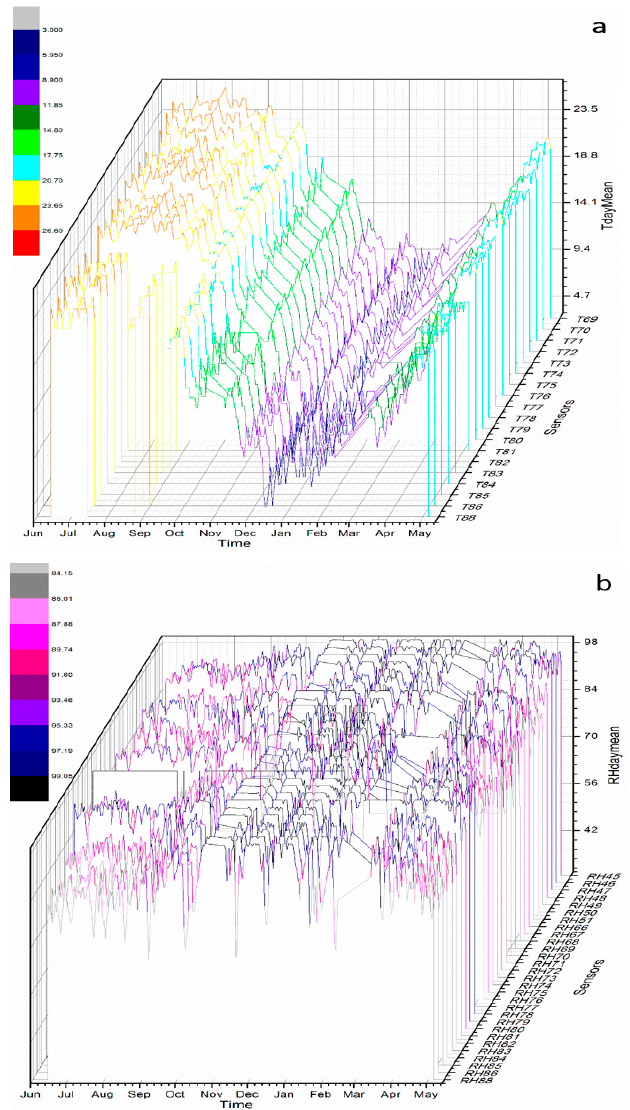
Figure 3. Multi-Curve Plot. ( a ) Tday m vs. time; ( b ) RHday m vs. time. Sensor locations are indicated in Figure 1.